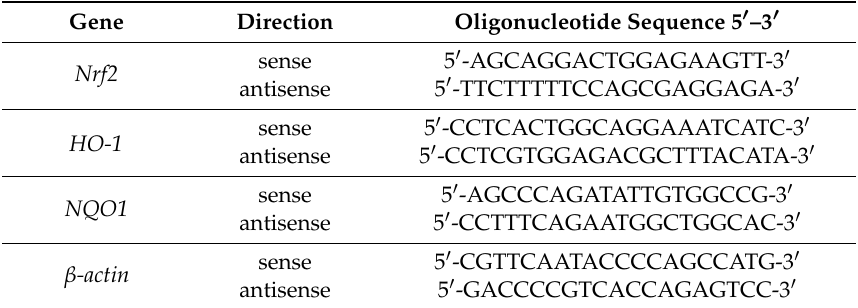
Table 1. The primers of Nrf2, HO-1, NQO1 and β -actin for quantitative reverse transcription-PCR